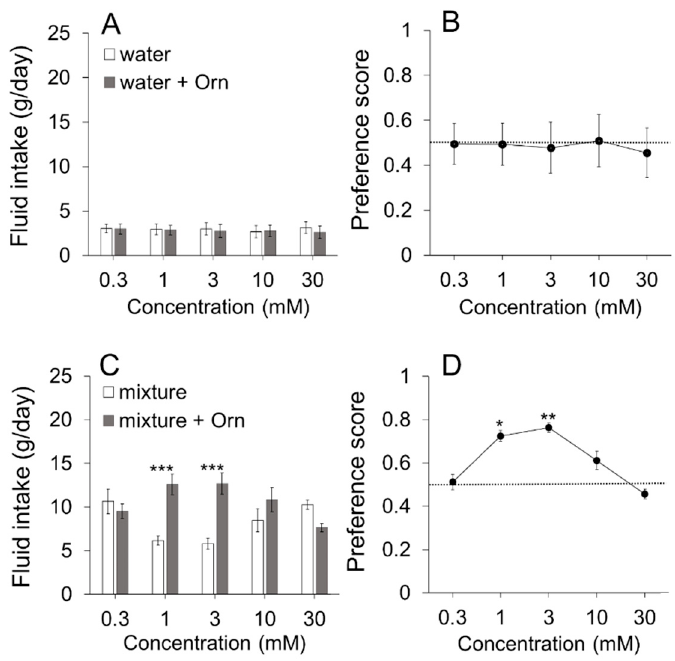
Figure 2. Additive effects of different concentrations of L-ornithine (Orn). ( A ) Water intake with or without five concentrations of Orn. ( B ) Preference score for water with Orn. ( C ) Intake of a mixture of 0.05 M MSG, 0.05 M sucrose, and 0.05 M NaCl with or without Orn. ( D ) Preference scores for the mixture with Orn. Each value is mean ± SE; n = 8. * p < 0.05, ** p < 0.01, *** p < 0.001.